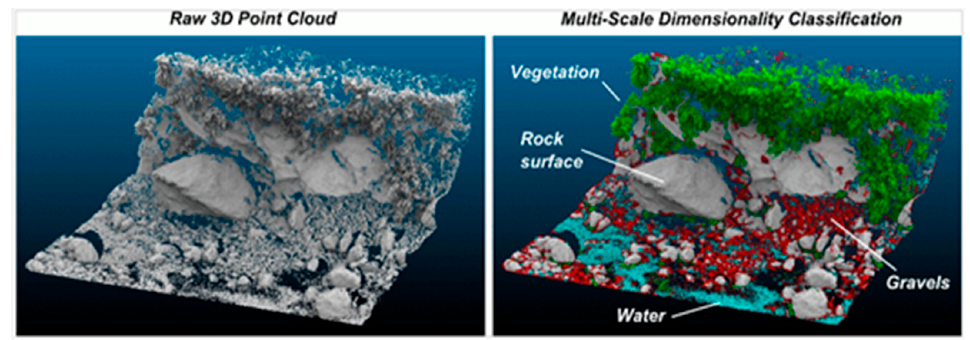
Figure 3. Multiscale dimensionality classification [28].